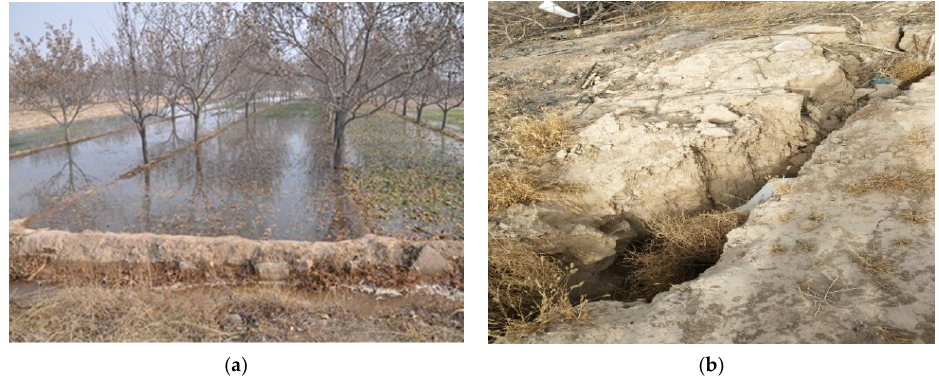
Figure 4. Heitai irrigation area: ( a ) flood irrigation; ( b ) ground crack.